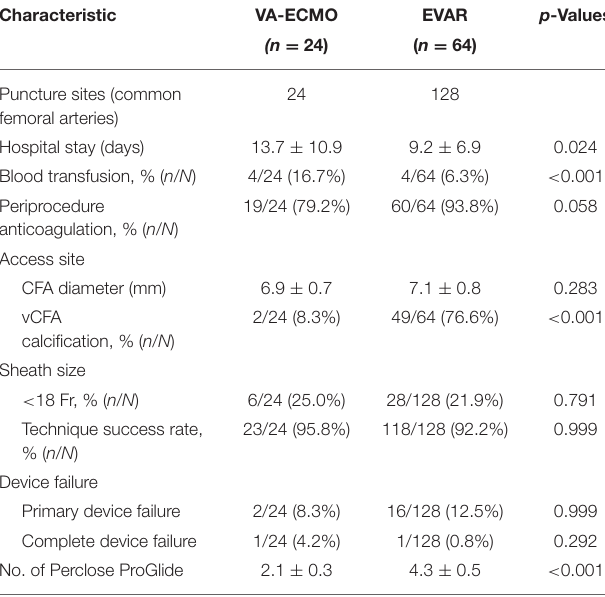
TABLE 2 | Periprocedural characteristics of VA-ECMO and EVAR patients * .